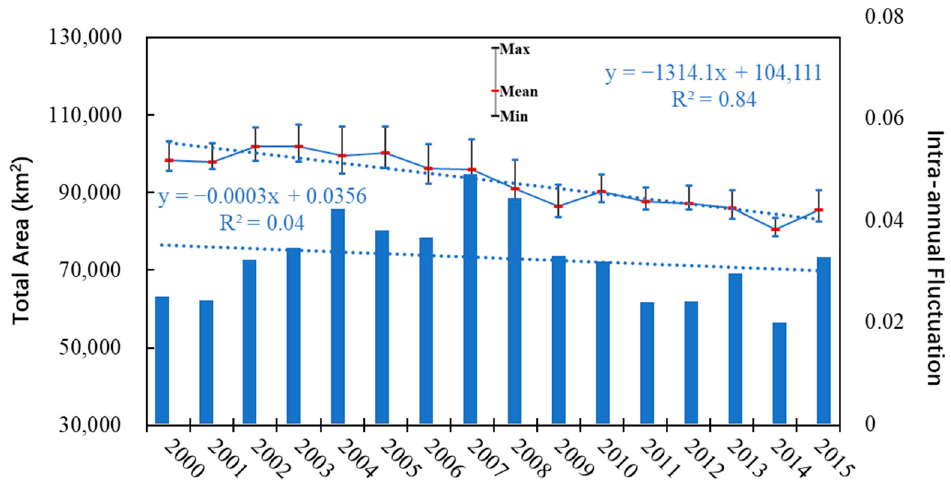
Figure 6. The yearly change (line) and intra-year fluctuation (blue bar) of the total lake area (the variables Max, Mean, and Min were calculated as the maximum, average, and minimum water area over the seven months within one year; the intra-annual fluctuation is the standard deviation of water areas over the seven months within one year).